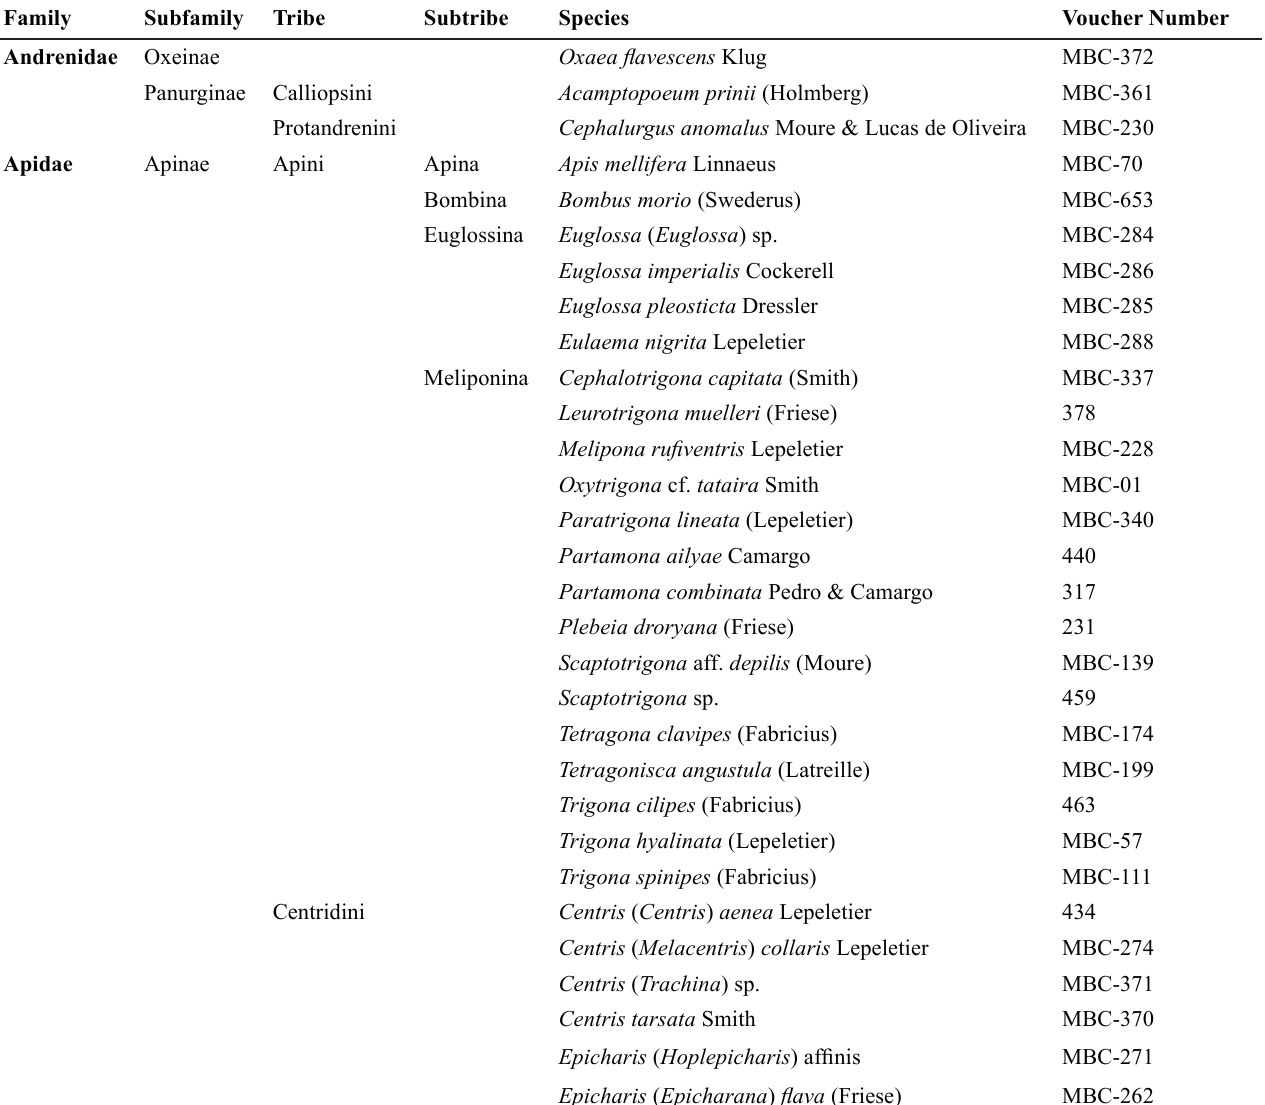
Table 1 . Bee species collected on the edge of the Semideciduous Forest of "Fazenda São José", Uberlândia-MG, in 2010 and 2011. Classification based on Silveira et al.